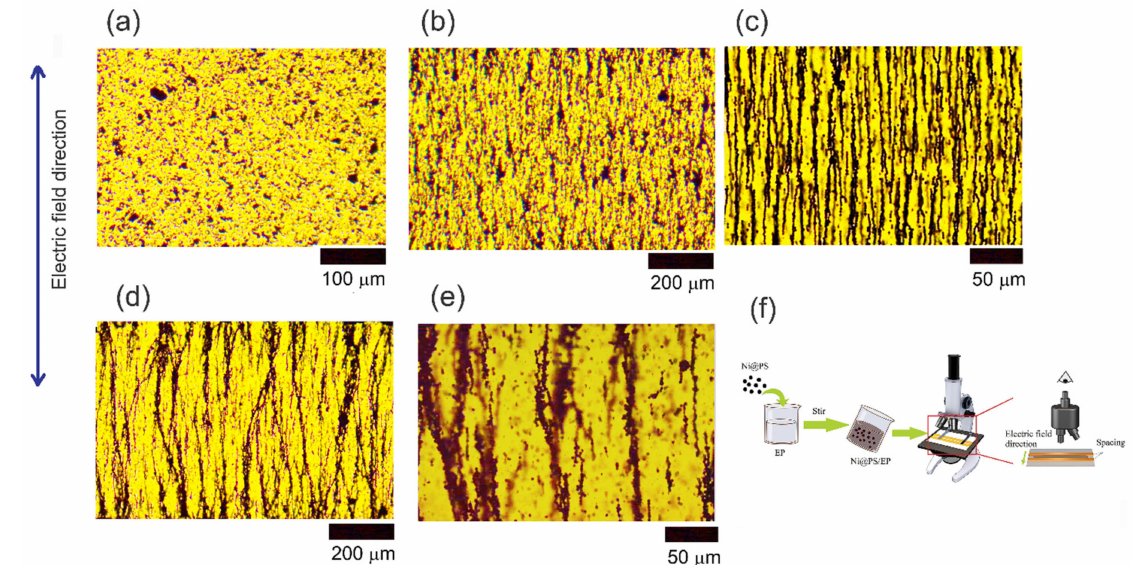
Figure 4. Optical microscopy of Ni@PS microspheres in EP oligomer under different electric field strength (V/mm): ( a ) 0, alignment of Ni@PS microspheres in EP with optical microscope.